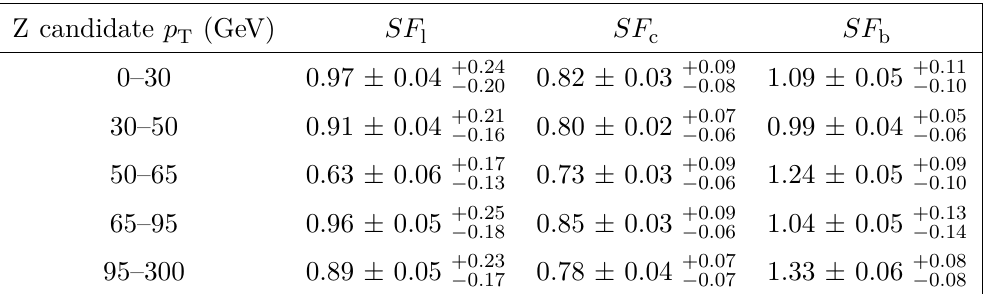
Table 3 . Values of Z +light jet SF muon channel, as a function of c -tagged jet p from the fit, the second is the systematic uncertainty.